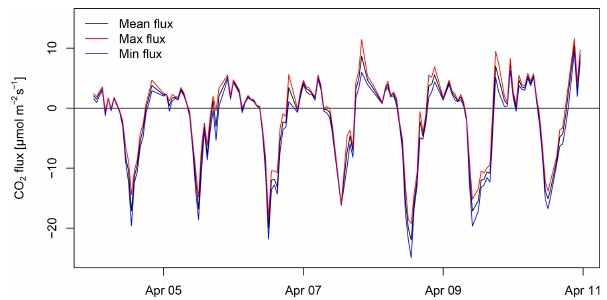
Figure 22. Range of CO 2 trace gas flux estimates observed by the true eddy accumulation method, accounting for the range of pos- sible flux estimates from four replicated measurements of the dry molar fraction difference between accumulated updrafts and down- drafts per 30min flux integration